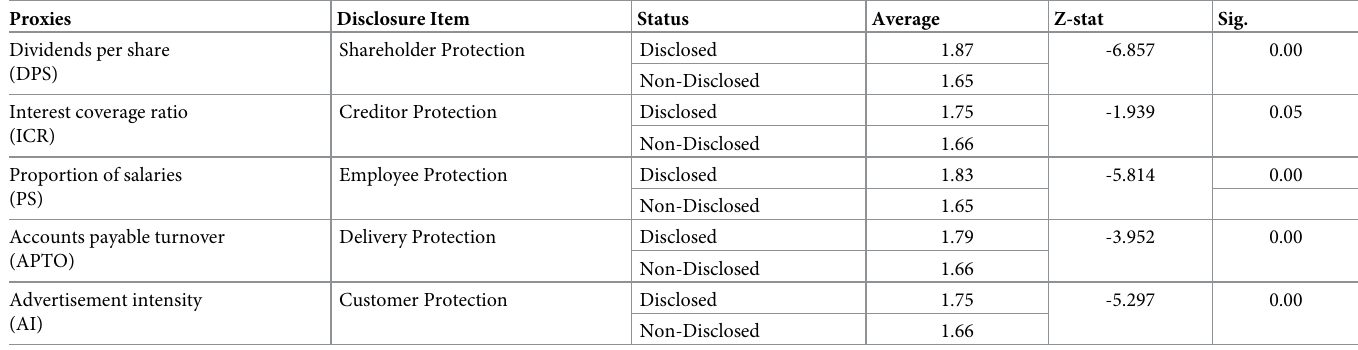
Table 3. Comparison of CSR item